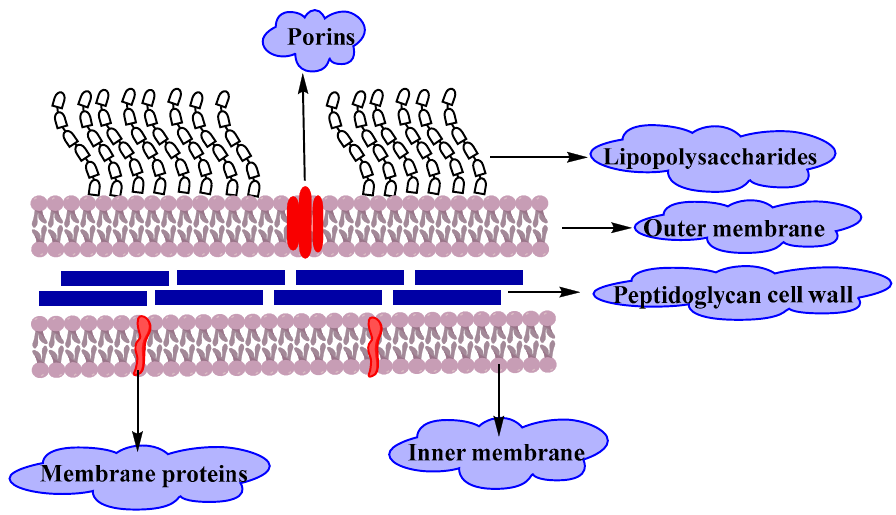
Figure 2. A diagram describes the cell wall structure of Gram-negative bacteria.